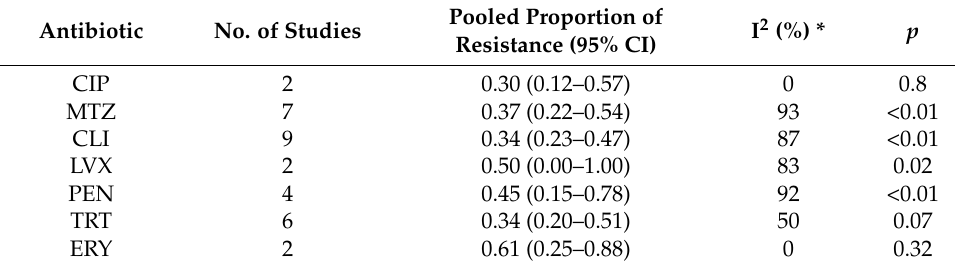
Table 3. Pooled proportion of resistance for Clostridium species. Antibiotic No. of